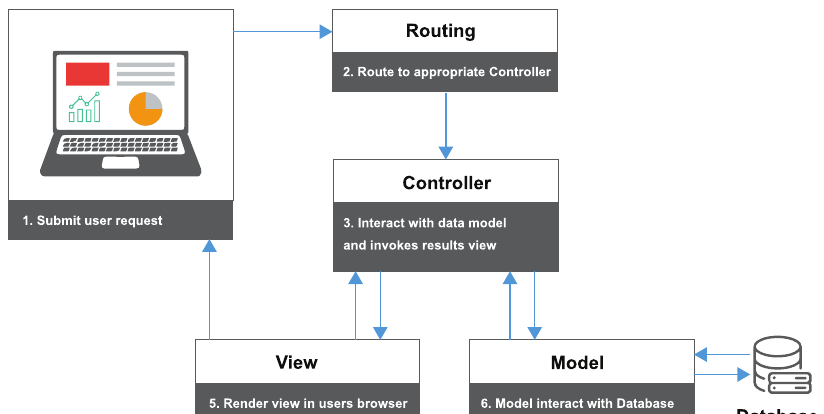
Figure 7. The architecture of the web monitoring platform illustrates the flow of actions from the user’s request to the point of receiving the